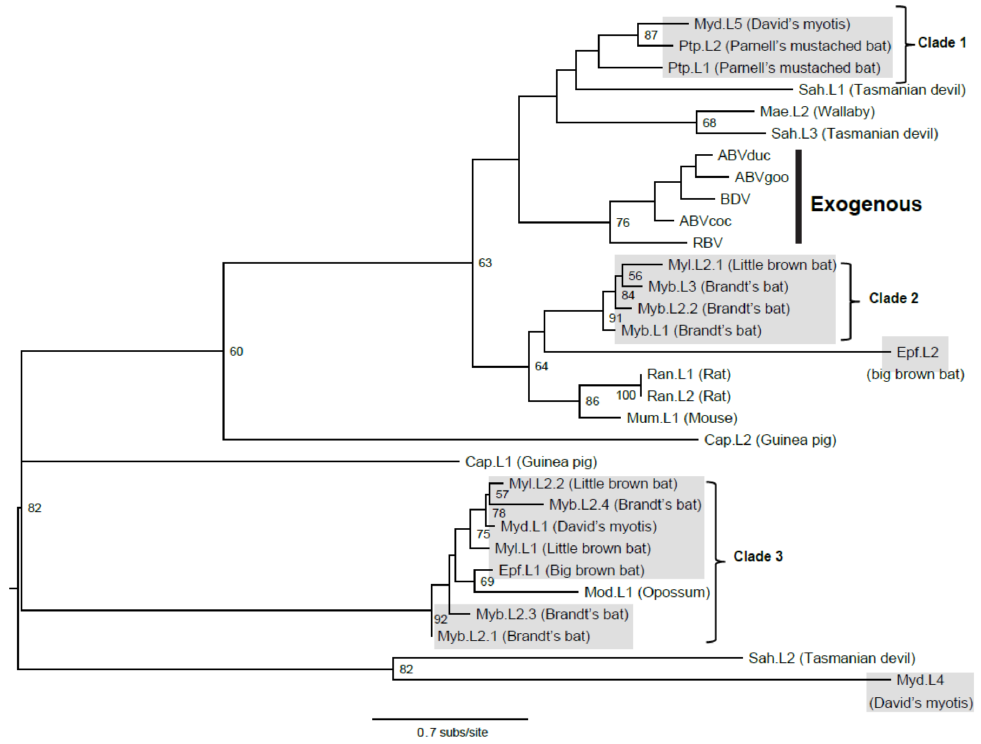
Figure 1. Phylogenetic positions of bat endogenous bornaviruses. EBLL protein sequences of bats and non-bats are used to construct the phylogenetic tree. Host names indicate viral lineages; the numbers denote viral elements in different contigs and the sub-numbers denote different viral elements in same contigs. The abbreviations can be found in Table 1 and Table S1. Exogenous bornaviruses are highlighted; all bat clades are marked. Bootstrap values lower than 50% are not shown. Branch lengths are drawn to a scale of amino acid substitutions per site (subs/site). The trees are midpoint rooted for purposes of clarity only. All bat EBLs are shaded in